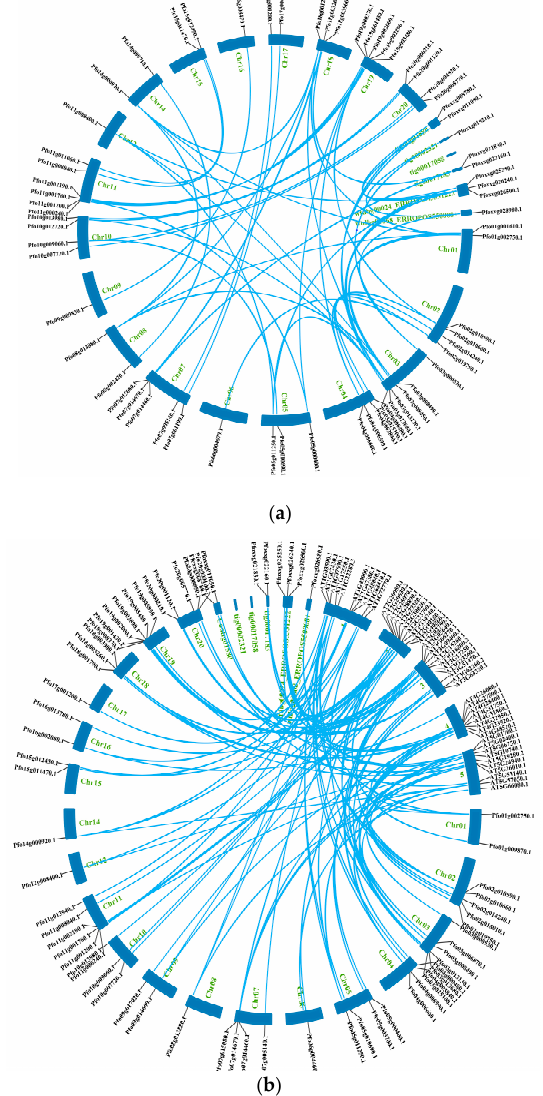
Figure 6. Collinearity analysis of PP2C gene families in different species: ( a ) Collinearity analysis of the PP2C gene family in P. fortunei ; ( b ) Collinearity analysis of PP2C gene families in P. fortune and A.